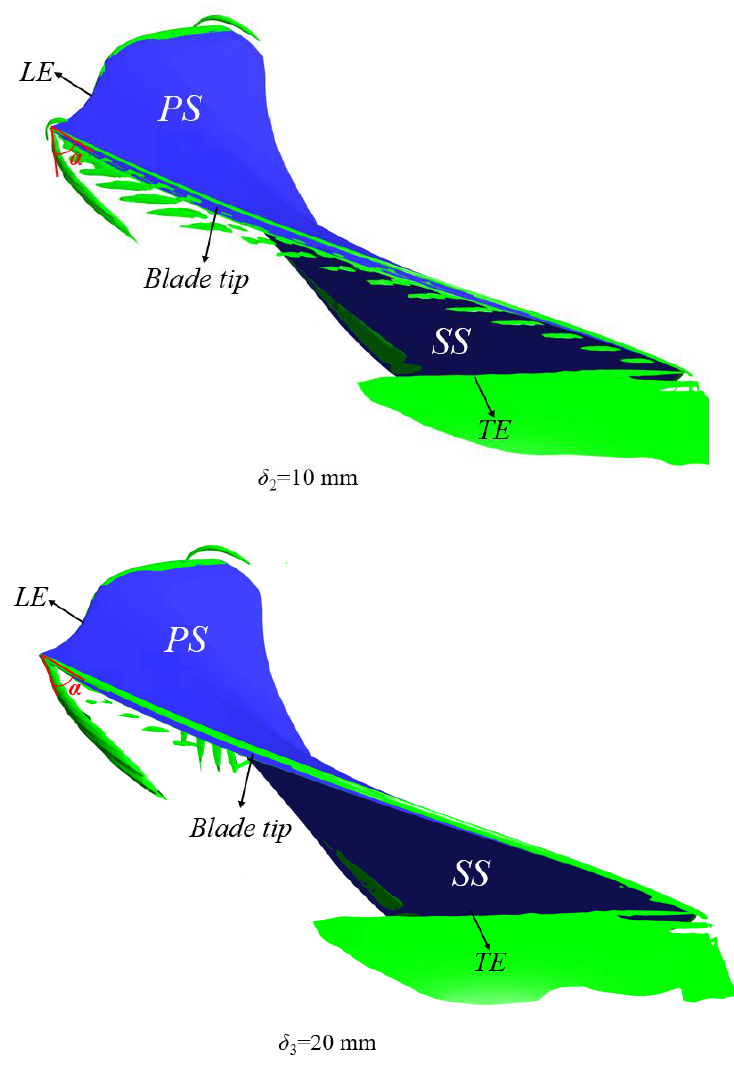
Figure 12. TLV structure under different gaps.